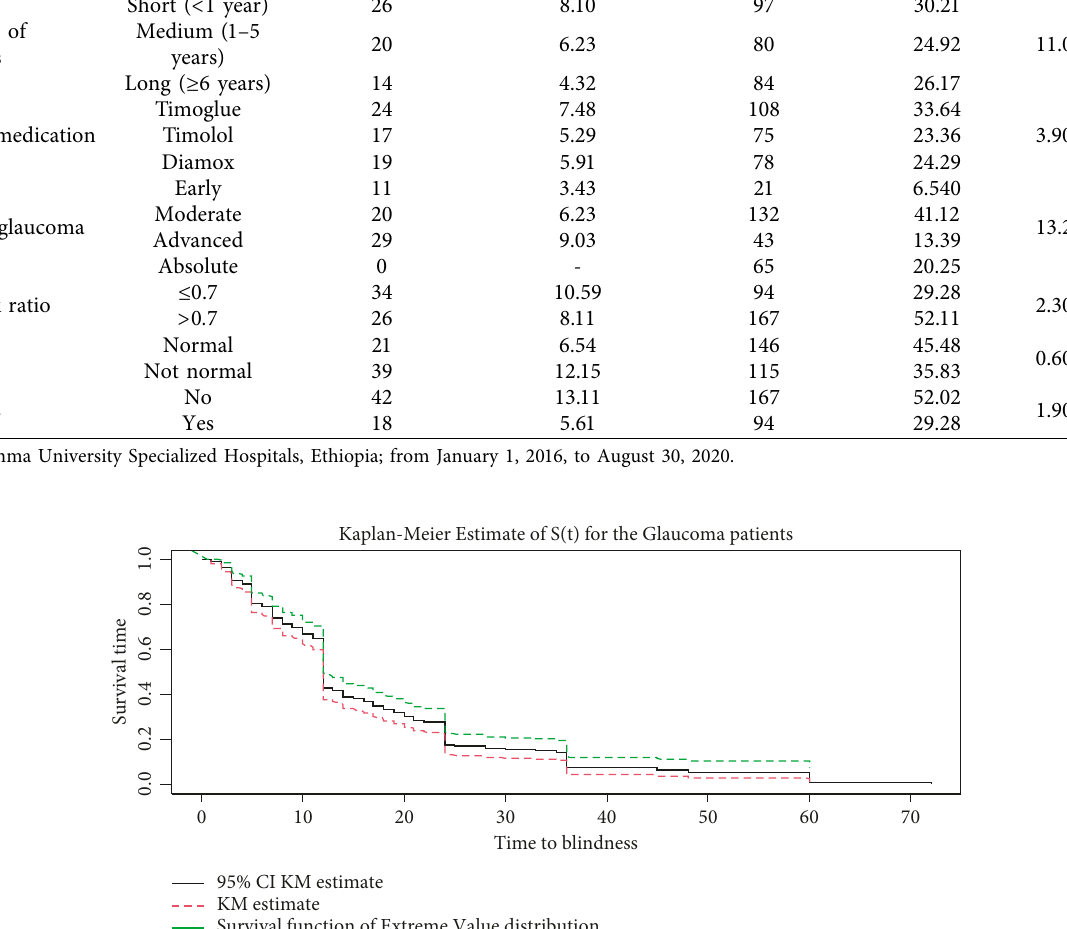
Table 2: Clinical variables of glaucoma patients’ at Jimma University Specialized Hospital from 2016 to 2020 ( n � 321). Covariates